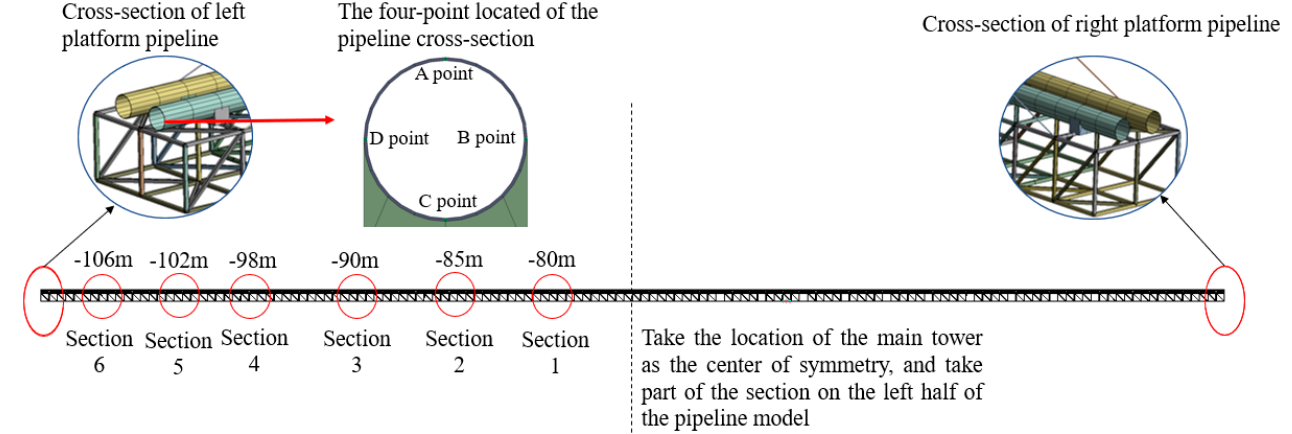
Figure 8. Schematic diagram of the cross-sectional location of the oil and gas transmission pipeline.